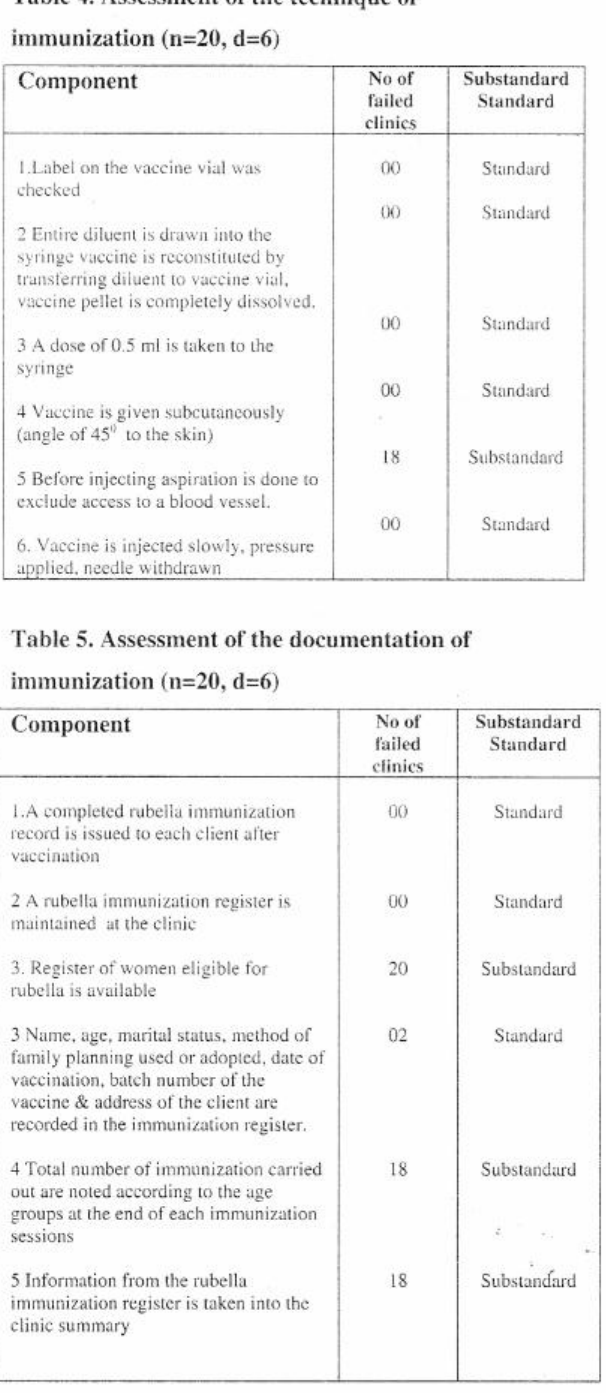
‘Table 4. Assessmentof the technique of